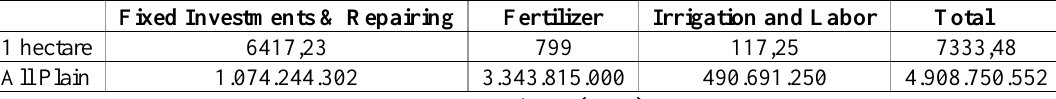
Table 3: The 25 years of irrigation cost in Harran Plain (167400ha) (US$). Fixed Investments & Repairing Fertilizer Irrigation and